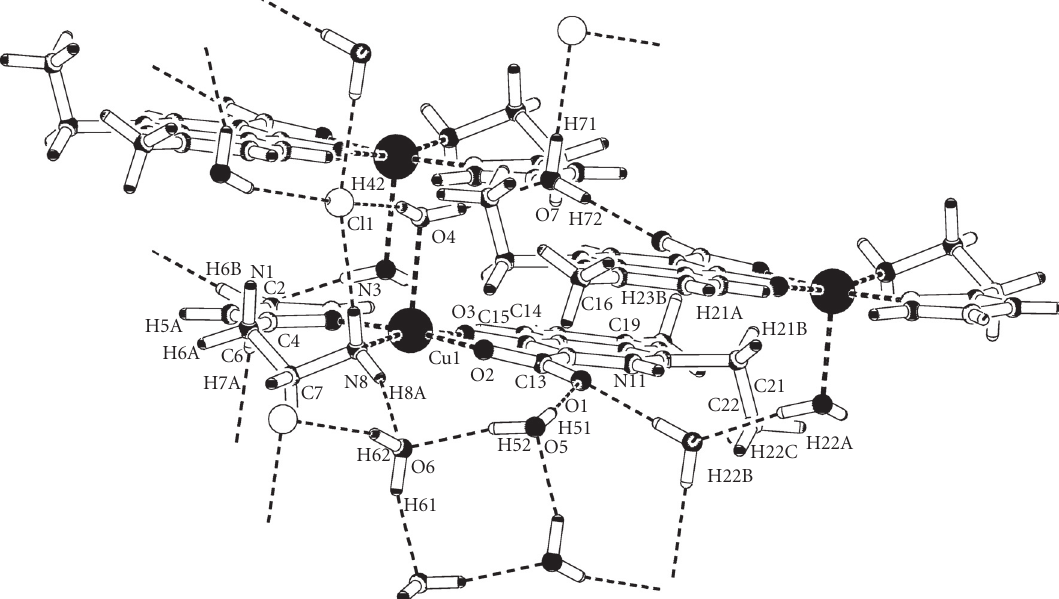
Figure 3: PLUTON plot showing the stacking between nalidixate rings and hydrogen bondings in the crystal of [Cu(hsm)(nal)H 2 O]Cl · 3H 2 O complex.